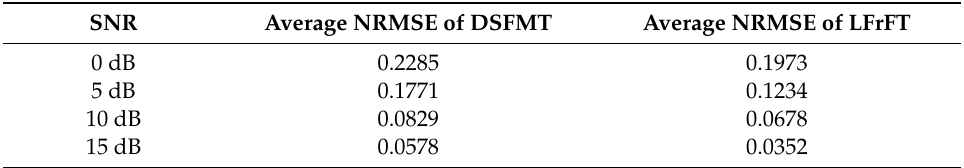
error under typical signal-to-noise ratios